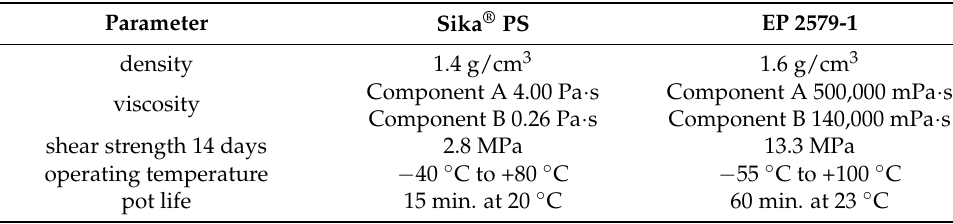
Table 1. Parameters of